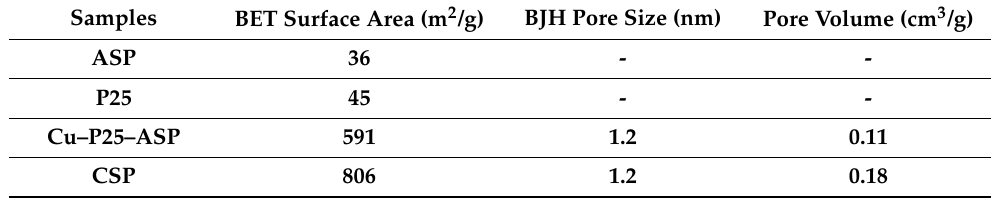
Table 2. List of BET surface areas, BJH pore sizes, or pore volumes for ASP, P25, Cu–P25–ASP, and